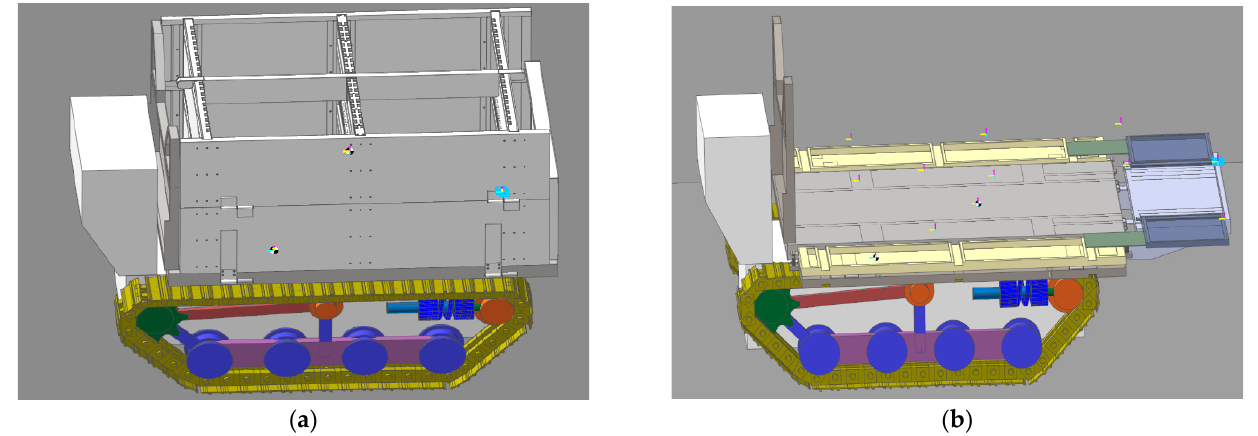
Figure 4. ( a ) Tracked vehicle used for loading bee frames when the loading box is folded, and ( b ) tracked vehicle used for loading beehives when the loading box is unfolded.